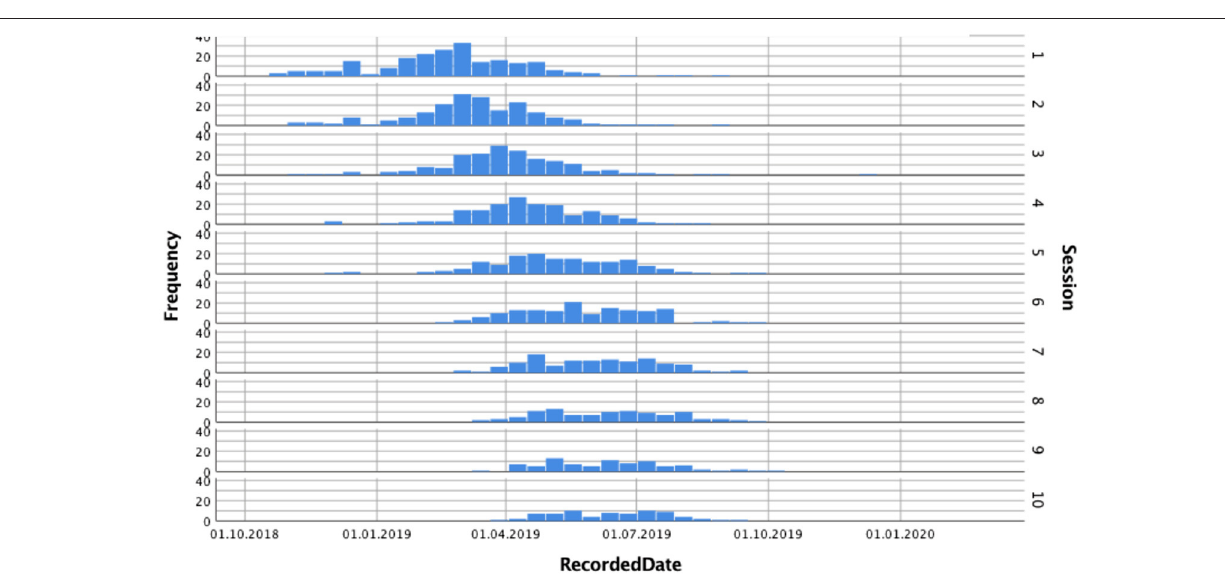
FIGURE 3 | Periodic distribution of coaching sessions. Histogram depicts the perodic distribution of coaching sessions in the period between October 2018 and November